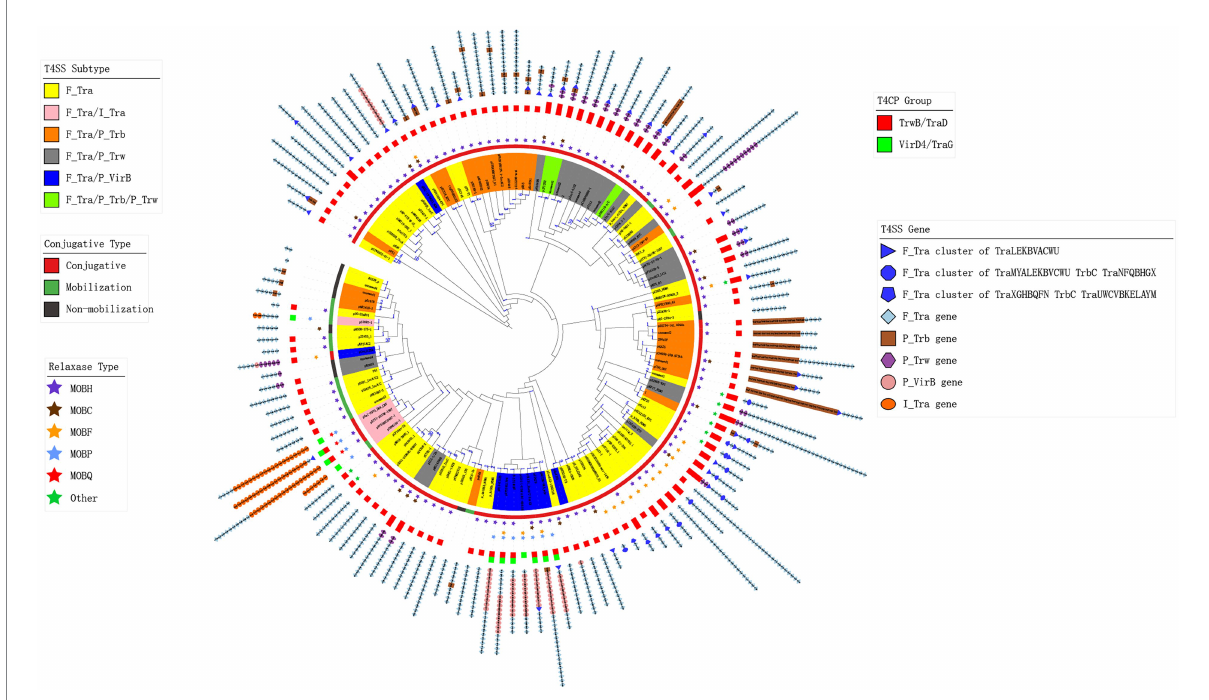
FIGURE 4 Gene content tree of the plasmid conjugative transfer system and its component types. The tree was constructed using the relaxase, T4CP and T4SS genes from representative plasmids. The number of plasmids represented by each node is marked on the branch. The colourful leaves represent the types of T4SS genes in plasmids. The conjugative types of the representative plasmids are shown by the strip plot. The types of relaxase genes are indicated by a star plot. The bar plot shows the types of T4CP genes in the plasmids. The concatenated colourful shapes represent the different types of T4SS genes in the